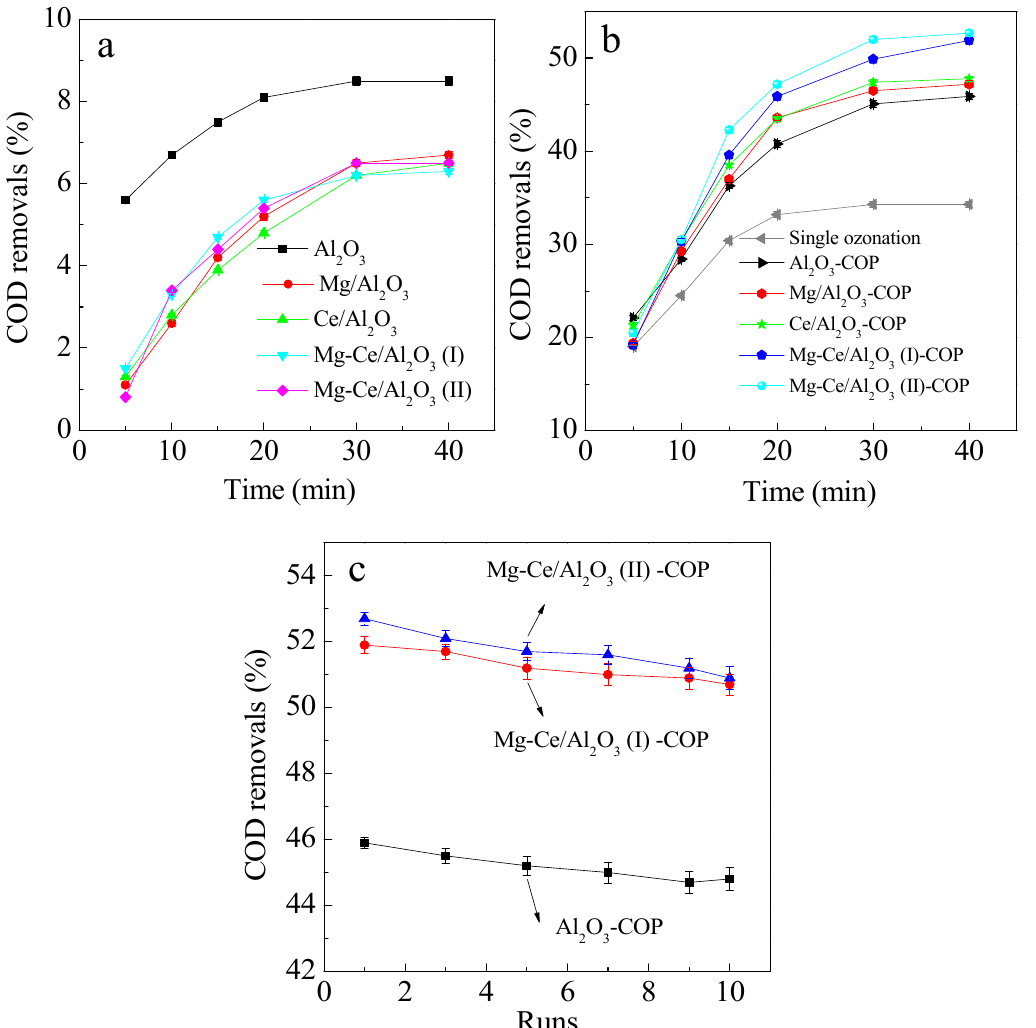
Figure 7. COD removals for RPRW by adsorption ( a ); by single ozonation and COPs ( b ); and by 10 repeated uses of COPs ( c ) (note: 0.5 g catalyst, 5 mg/min ozone, and 30